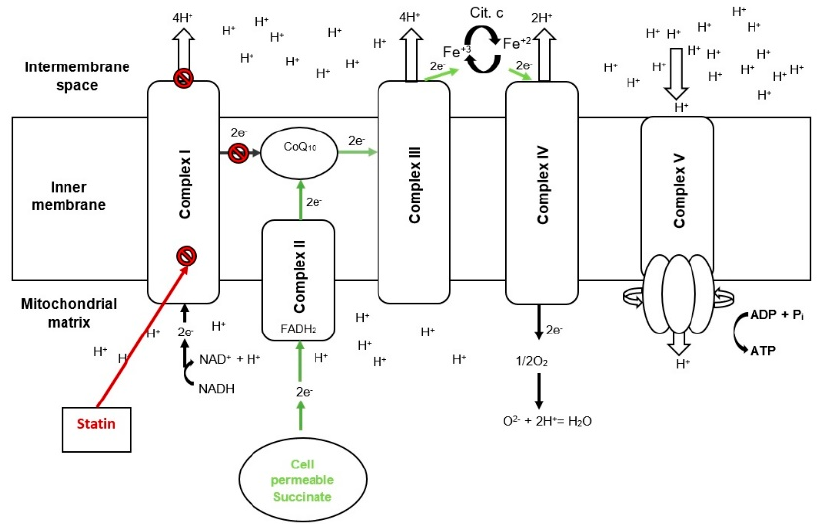
Figure 6. Cell permeable succinate bypasses statin − induced complex I mitochondrial dysfunction. Scheme 10. ubiquinone; e − , electron; FADH 2 , dihydroflavine-adenine dinucleotide; Fe +3 , iron(III); Fe +2 , iron(II); H + , proton; NAD + , Nicotinamide adenine dinucleotide oxidized form; NADH, Nicotinamide adenine dinucleotide reduced form; OXPHOS, oxidative phosphorylation.